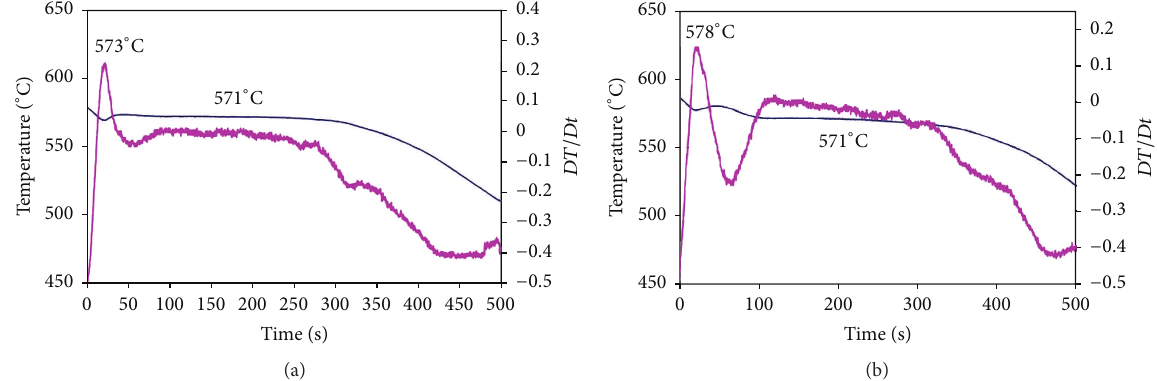
Figure 5: Solidification curve and first derivative for (a) E0 alloy and (b) E9 alloy.